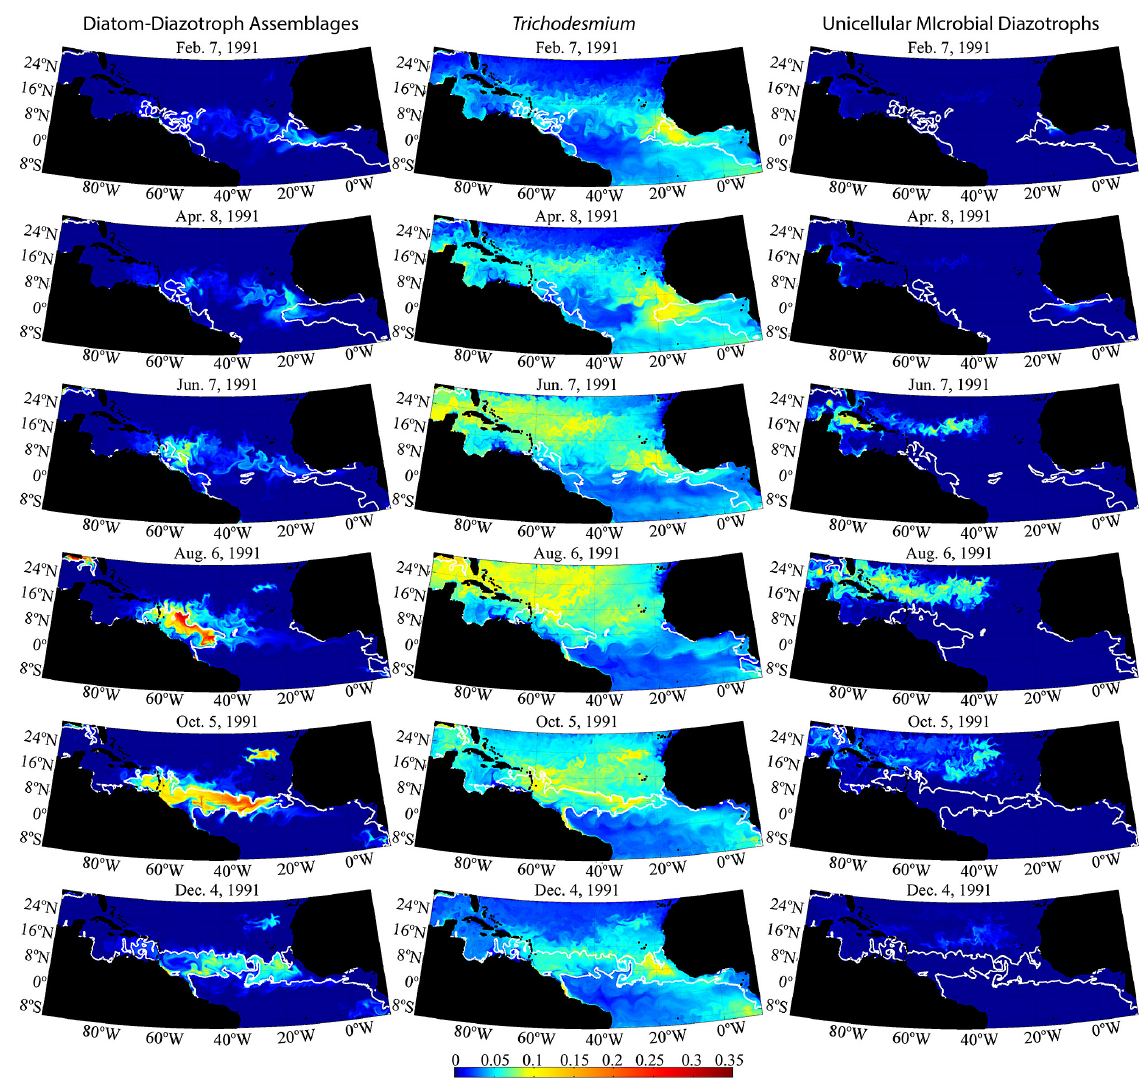
Figure 5. Seasonal variability in model surface DDAs (left), Trichodesmium (middle), and UMDs (right) concentrations (µmol N L − 1 ) . White lines show the 35 salinity